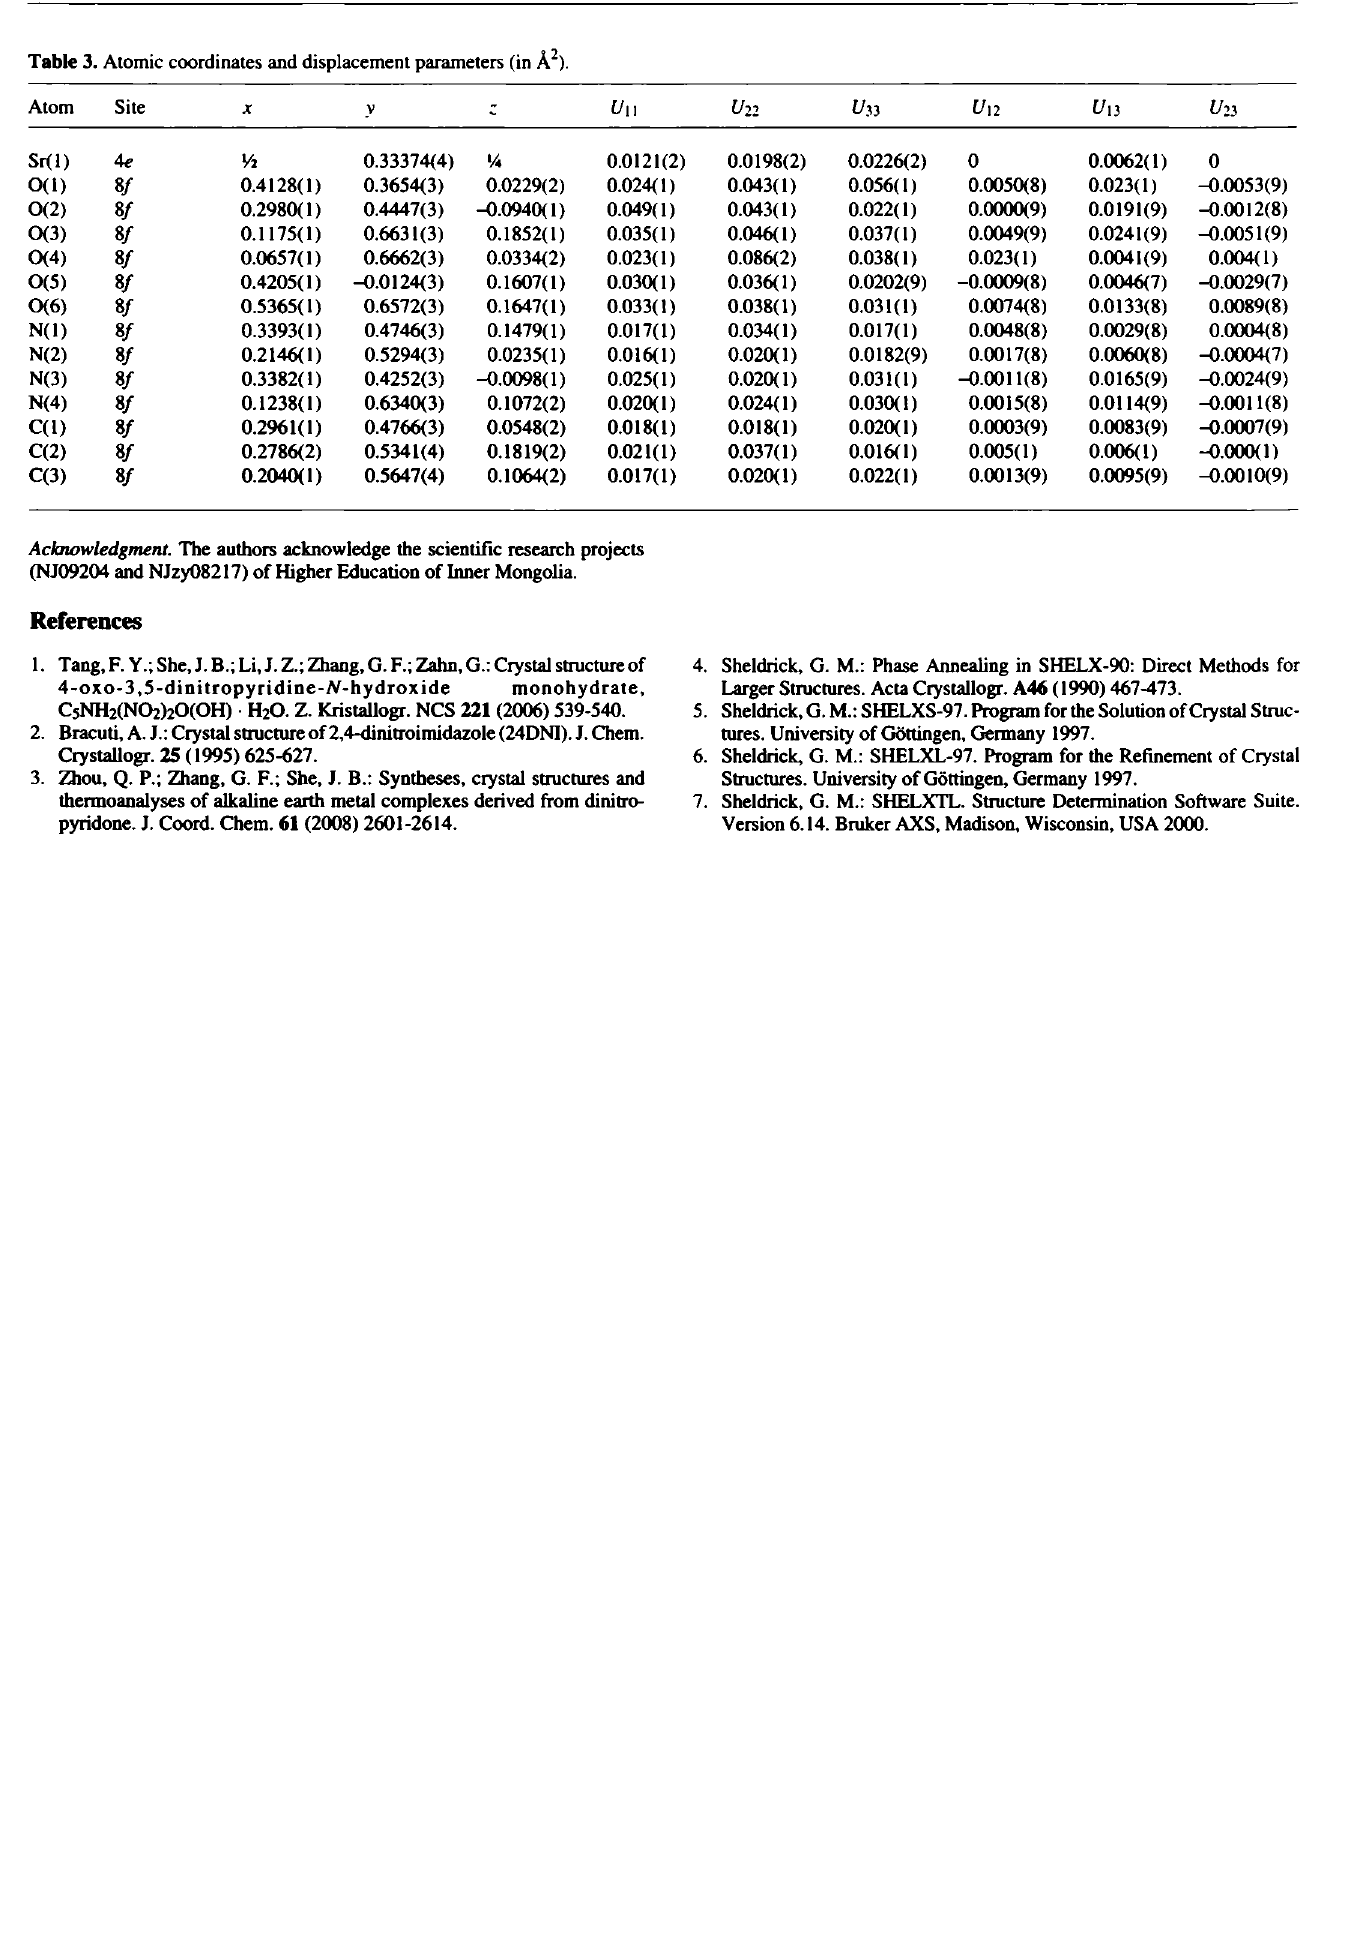
Table 3. Atomic coordinates and displacement parameters (in À 2